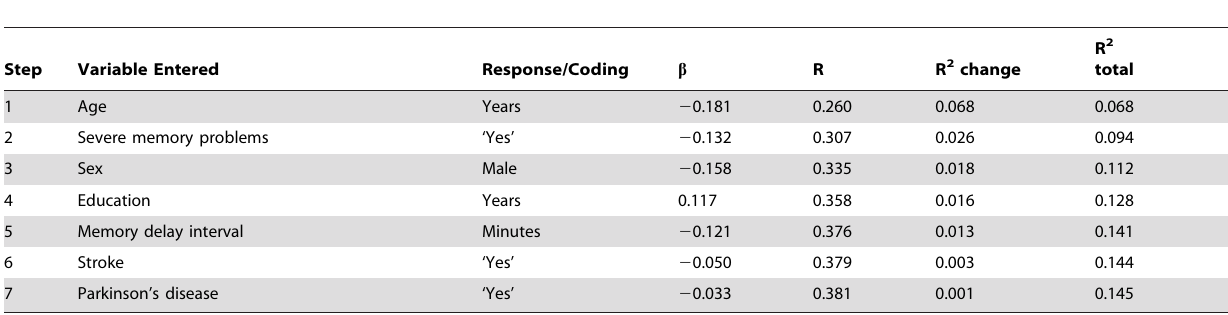
Table 2. Summary of stepwise multiple regression on recognition memory test score among participants age 50 and older in the Anonymous Internet Sample.